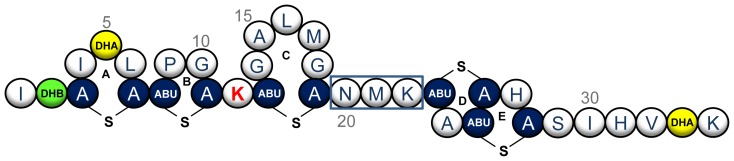
Structure of nisin A.The structure of nisin A is depicted, showing the location of its five (β-methyl)lanthionine rings (A–E) and modified residues dehydroalanine (yellow) and dehydrobutyrine (green). Position K12 is highlighted in red and the hinge region is boxed.